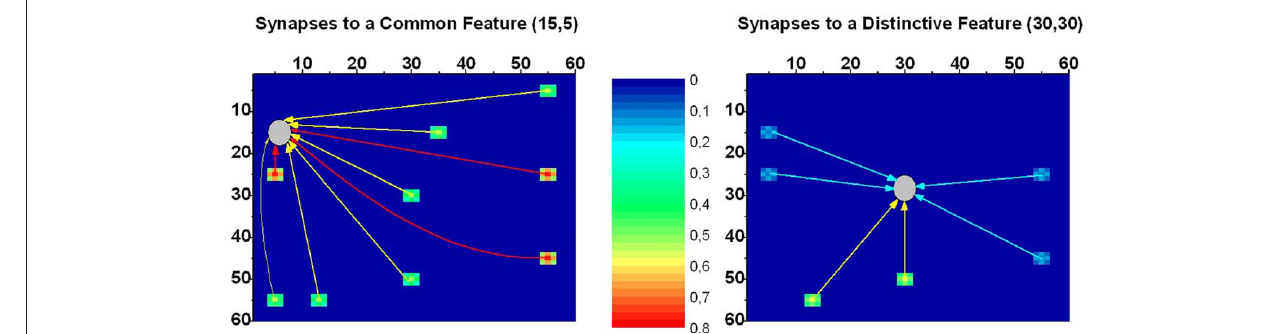
common features are stronger (red color) than those coming from the six distinctive features (green color), since common features are more often encountered during training; (ii) a distinctive feature (right panel) receive synapses only from the other six features of the same object (obj4). Synapses from the distinctive features have the same strength as in the left panel (green color), whereas synapses from common to distinctive features are weaker (cyan color) as a consequence of depression (see text for details). Hence, common features are strongly interconnected with other common features, but do not evoke distinctive features. Distinctive features are moderately interconnected, and can evoke both other common features and other distinctive features. Finally, it is worth noting that a neuron receives synapses not only from neurons coding for the “exact” feature of the same object, but also from proximal neurons, thereby constituting an “activation bubble.” This implements a similarity